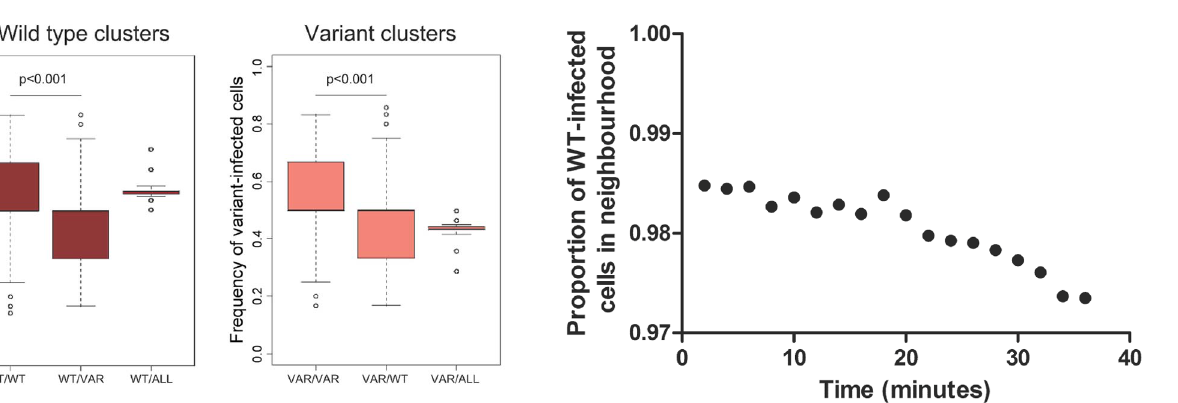
Figure 4. Infected cells in the neighbourhood of CD8 + T cells secreting non-lytic factors. The mean fraction of wild type-infected cells neighbouring secreting CD8 + T cells was evaluated over time. We tracked the proportion of wild type- and variant-infected cells in the immediate neighbourhood (radius=1, i.e. 26 neighbours) of 5,425 se- creting CD8 + T cells. In these runs, CD8 + T cells secreted non-lytic factors for 30 mins after triggering and were tracked for 34 minutes. The proportion of wild type-infected cells was high (i.e. the majority of affected cells were wild-type infected, conferring an advantage upon variant-infected cells), but not 100% (i.e. some variant-infected were also affected by the factor) and the proportion of wild type-infected cells decreased significantly over time (i.e. the spatial heterogeneity that conferred an advantage upon escape variants was short lived). The correlation between the proportion of wild type-infected cells and time during the 30 mins post CD8 + T cell-triggering was significant, Spearman correlation coefficient= 2 0.93, p , 10 2 6